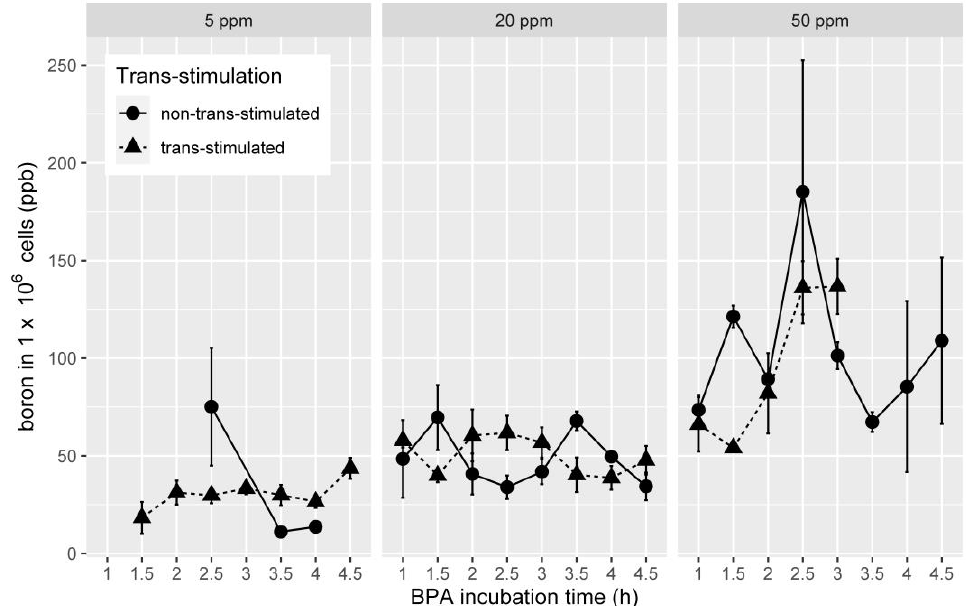
Figure 3. Line charts with error bars for standard error (SE) indicating boron content independent of BPA concentration (5, 20 and 50 ppm) and BPA incubation time (ppb = parts per billion, circles indicate non-trans-stimulated and triangles trans-stimulated cells).